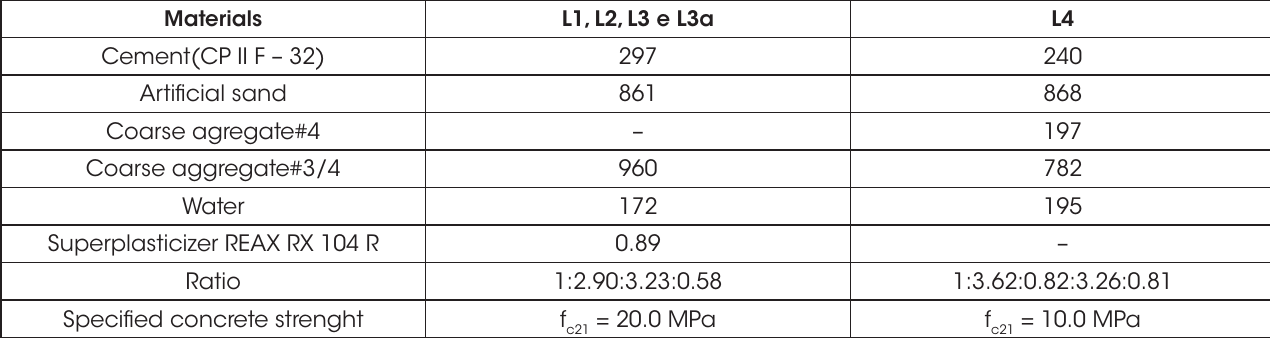
Superplasticizer REAX RX 104